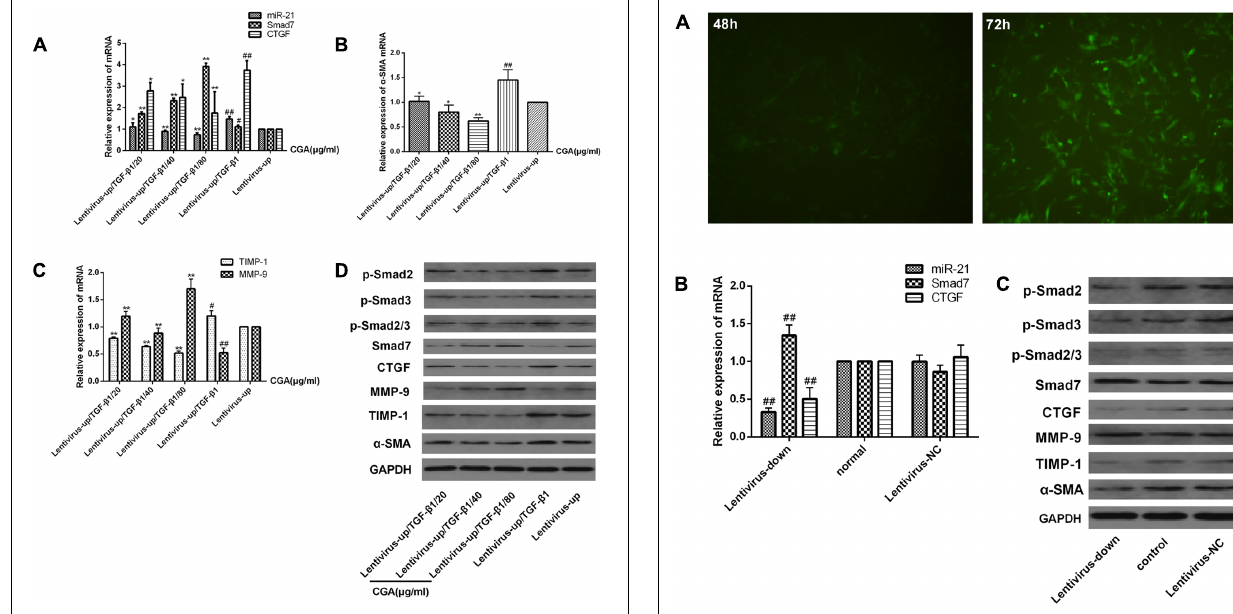
FIGURE 6 | Verification of downstream signaling molecules in LX2 cells after miR-21 knockdown. (A) LX2 cells were transfected with lentivirus, and the expression of GFP was observed with a fluorescence microscope after 48 and 72 h. (B) The expression of miR-21, Smad7 and CTGF was measured by quantitative real-time PCR. (C) The protein expression was detected by western blotting. Data are shown as the means ± SD, and significant differences were determined by one-way ANOVA. ## P < 0.01 for lentivirus-down group vs. normal